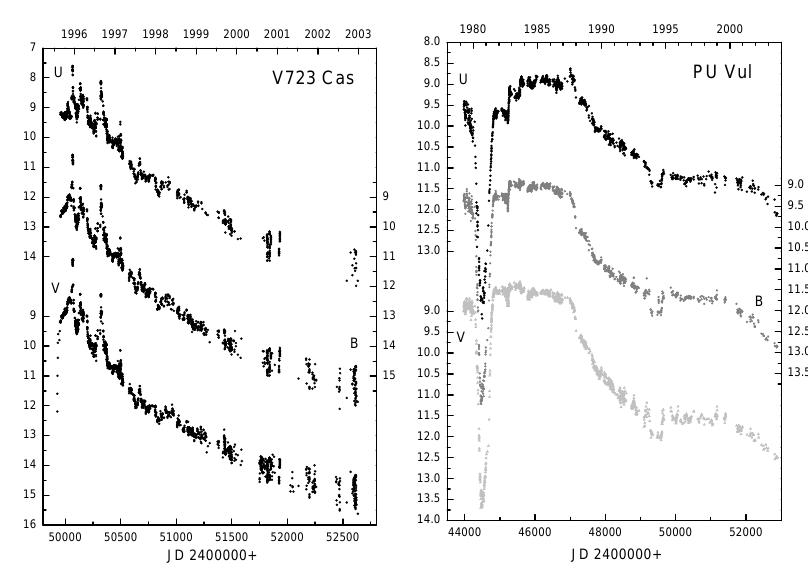
Fig. 1. UBV light curves of V723 Cas (left) and PU Vul